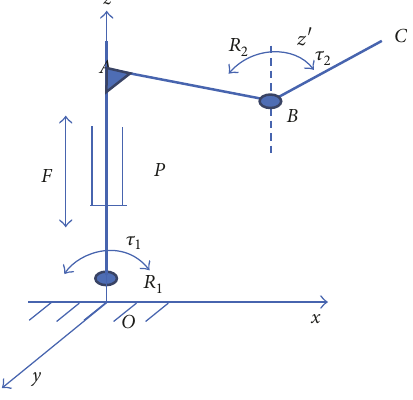
Figure 4: Schematic diagram of the robot.